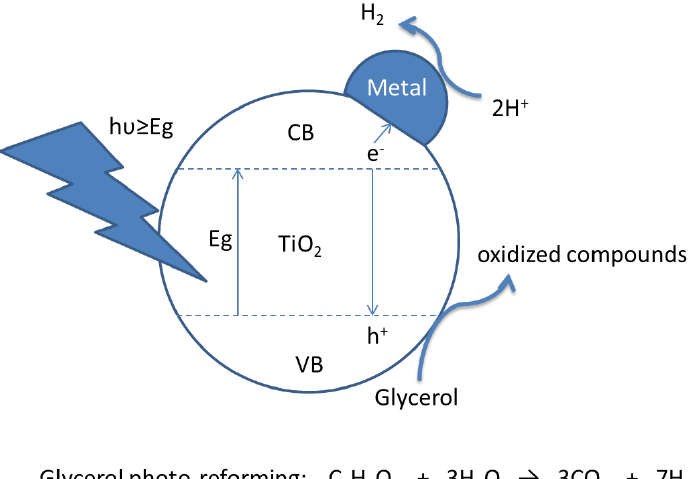
Figure 1. Activation of titania using a metal as a co-catalyst.